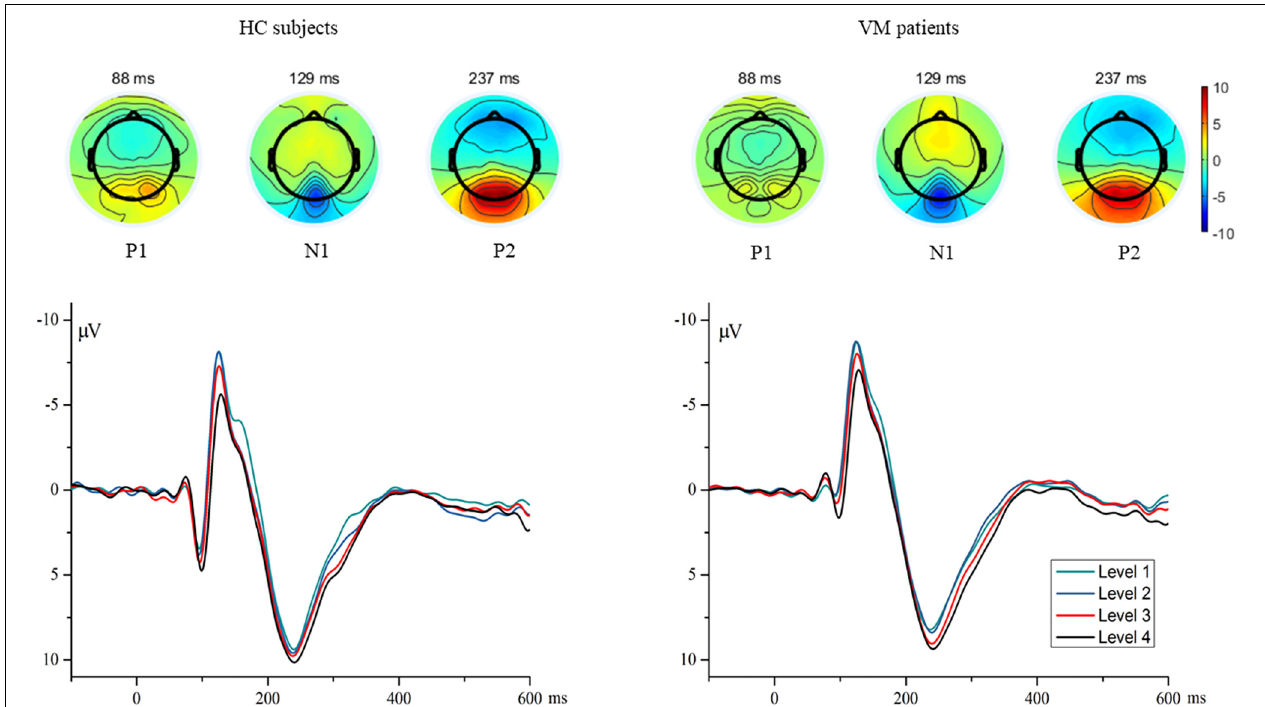
FIGURE 1 | The topographies show the P1 (88 ms), N1 (129 ms), and P2 (237 ms) VEP and are given separately for HC subjects and VM patients. Grand average VEP waveforms recorded at channel Oz are shown for different luminance ratios (Levels 1–4). Levels 1 and 4 refer to the smallest (12.5%) and largest (50%) proportions of white pixels in the stimulus pattern, respectively. VEP, visual evoked potential; HC, healthy control; VM, vestibular